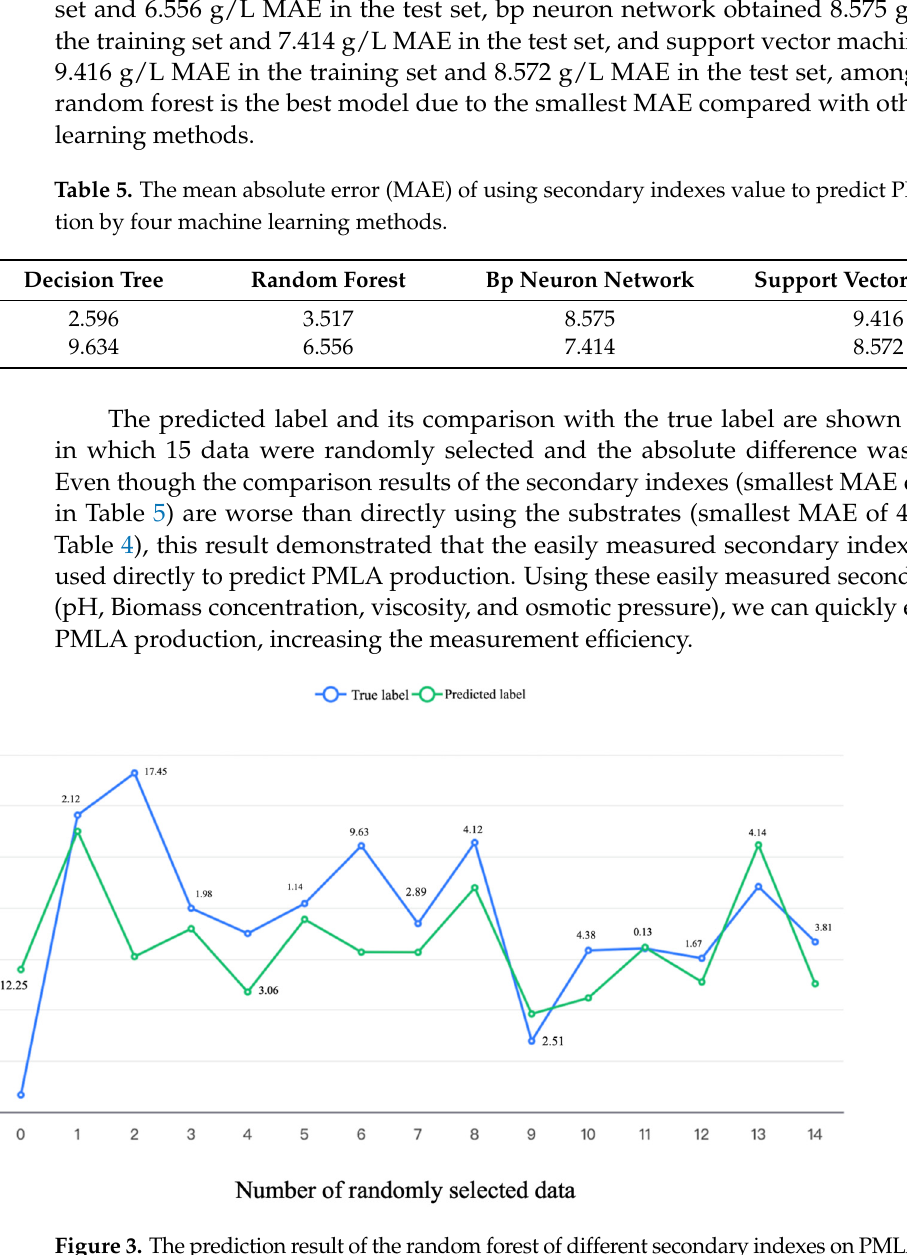
Figure 3. The prediction result of the random forest of different secondary indexes on PMLA pro- duction.